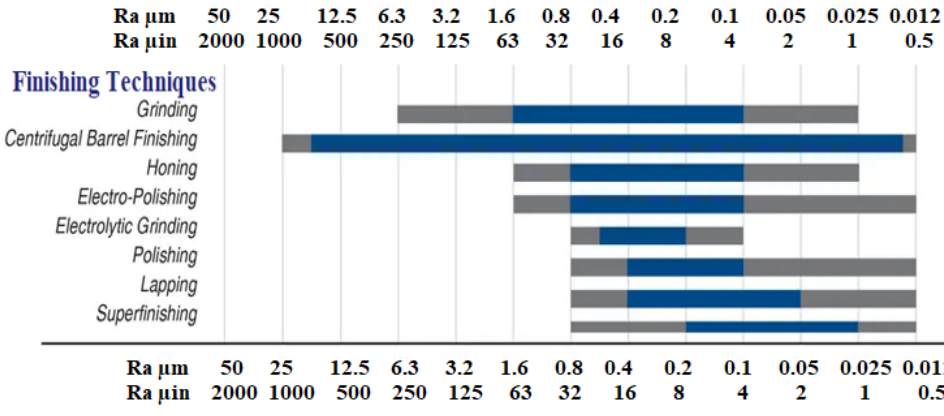
Figure 4. Surface roughness range comparison for traditional finishing processes. The comparison of surface roughness of advanced finishing techniques, i.e., nano fin- ishing techniques, is shown in Figure 5 below. Figure 5. Surface roughness range comparison for nano finishing processes.